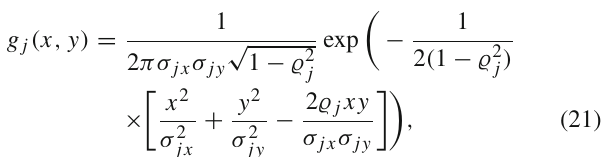
pulls averaged over the same radial distance (lower left) or angle (lower right). The error bars in the lower plot denote the standard error in the mean of the pulls in each bin. The fluctuations observed in the radial projection of the residuals are included in the uncertainty